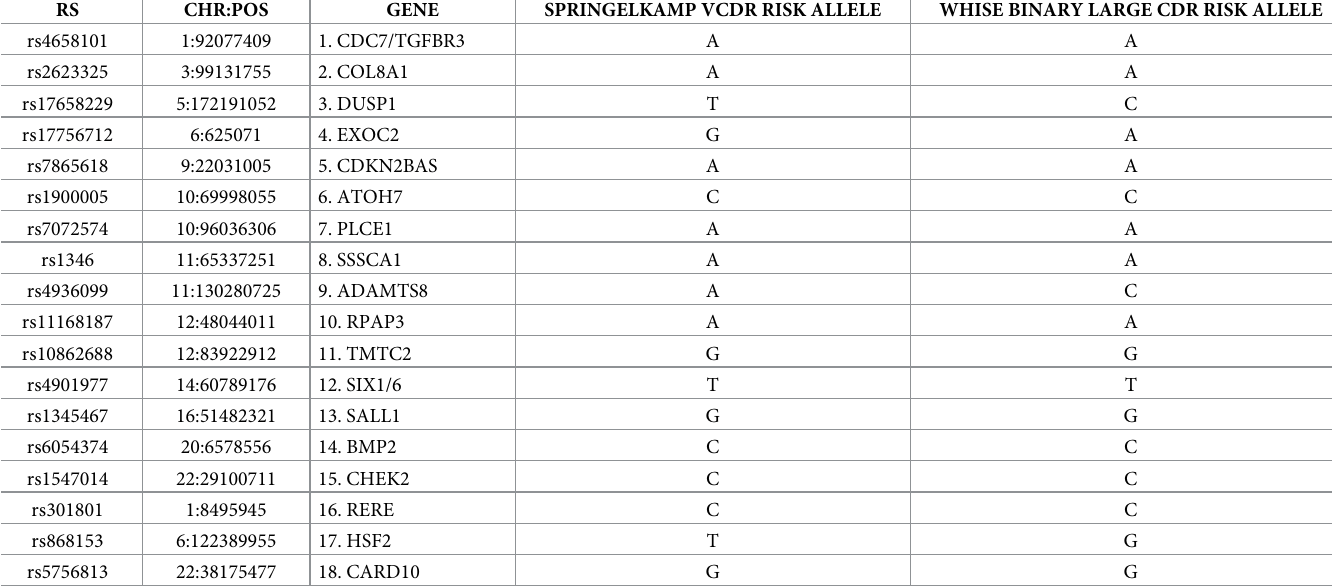
Table 1. 18 candidate SNPs associated with vertical cup-to-disc ratio.